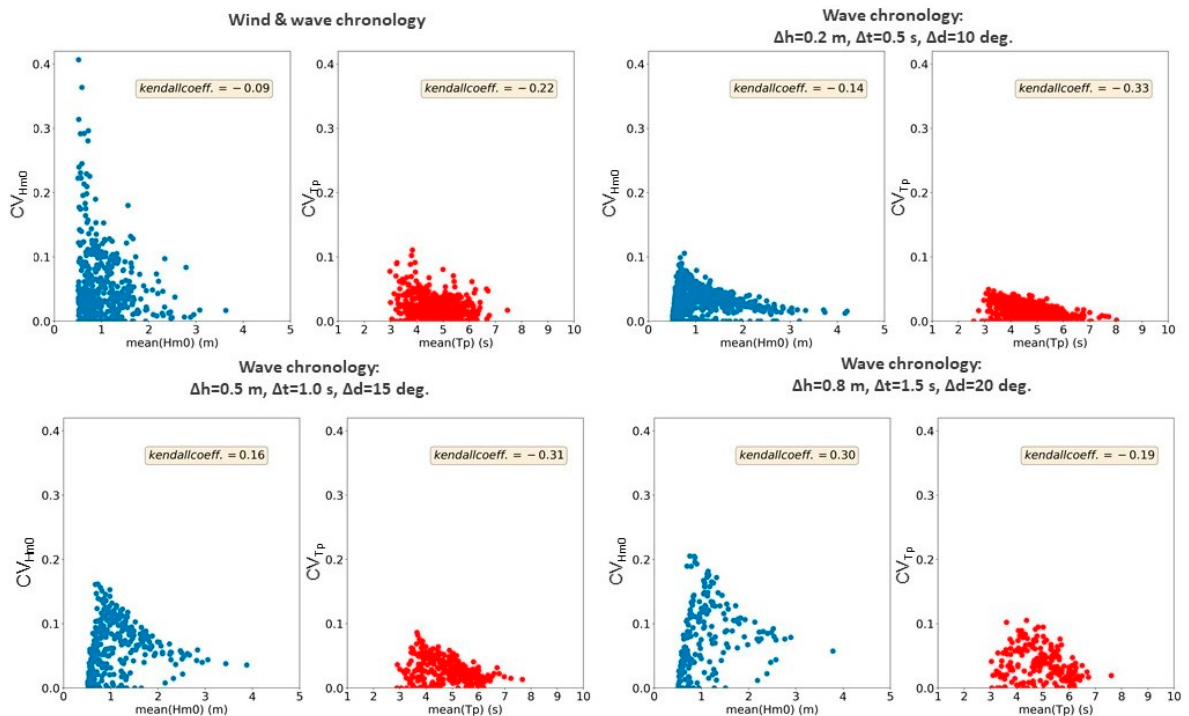
Figure 8. Scatter diagrams of the coefficients of variation towards the mean values of H m 0 and T p of the produced wave events using the four chronology-based reduction techniques.